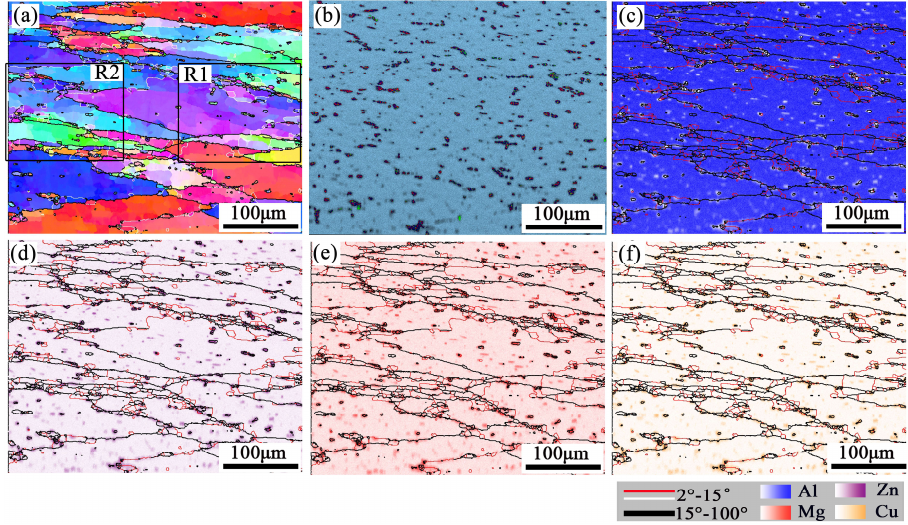
Figure 7. ( a ) EBSD-IPF map ( b ) EDS map and energy spectrum analysis maps: ( c ) Al, ( d ) Zn, ( e ) Mg, ( f ) Cu at 380 °C/0.001 s −1 .